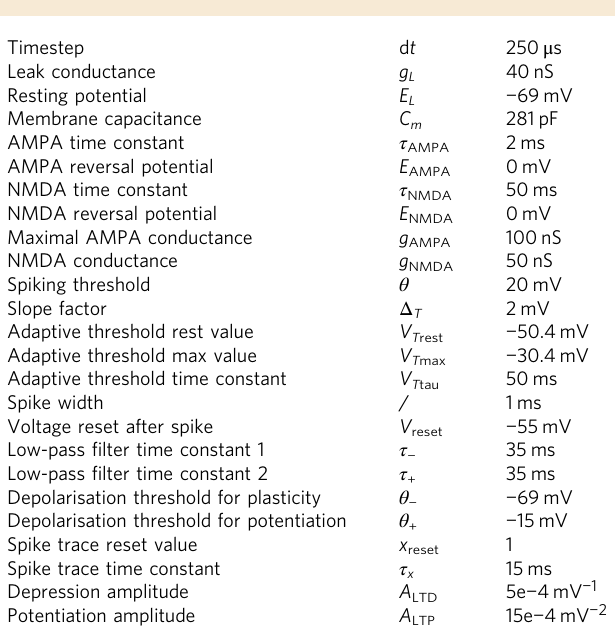
Table 4 Reduced neuron parameters